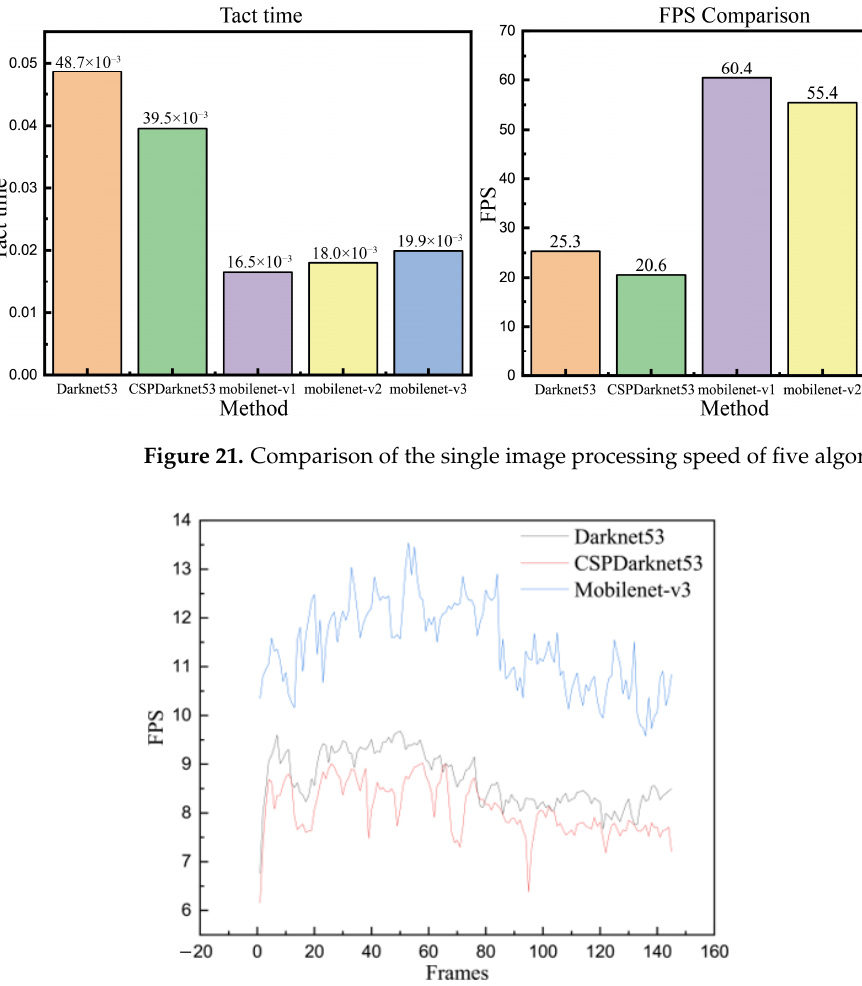
Figure 22. The FPS comparison of SCPDarknet53, Darknet53, and Mobilenet-v3.